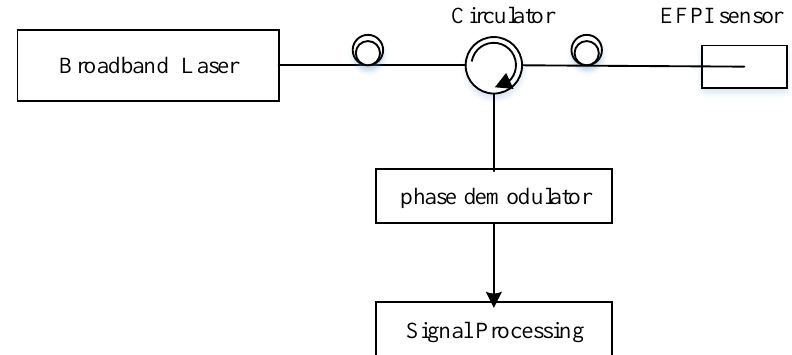
Figure 3. Schematic of phase demodulation system.